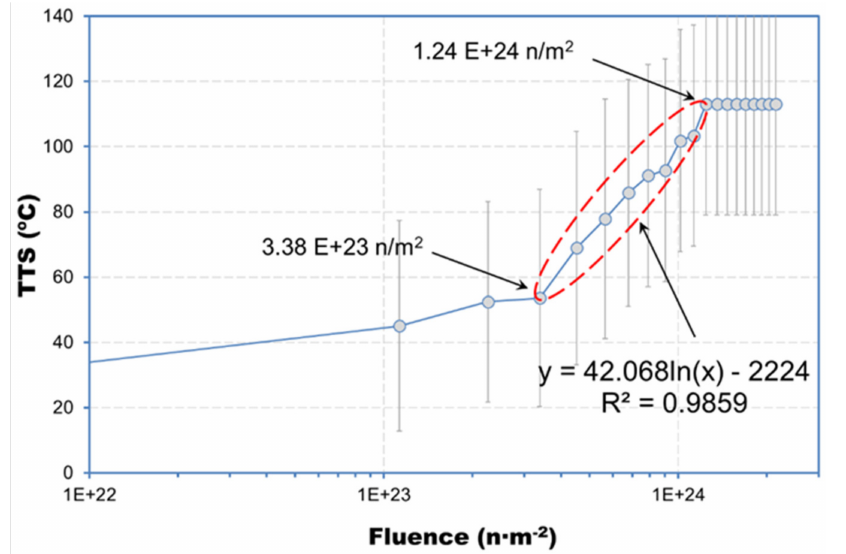
Figure 14. The graph shows the average influence of the fluence on the TTS. A linear relation with R 2 = 0.9859 can be observed for fluences between 3.38 × 10 23 and 1.24 × 10 24 n m − 2